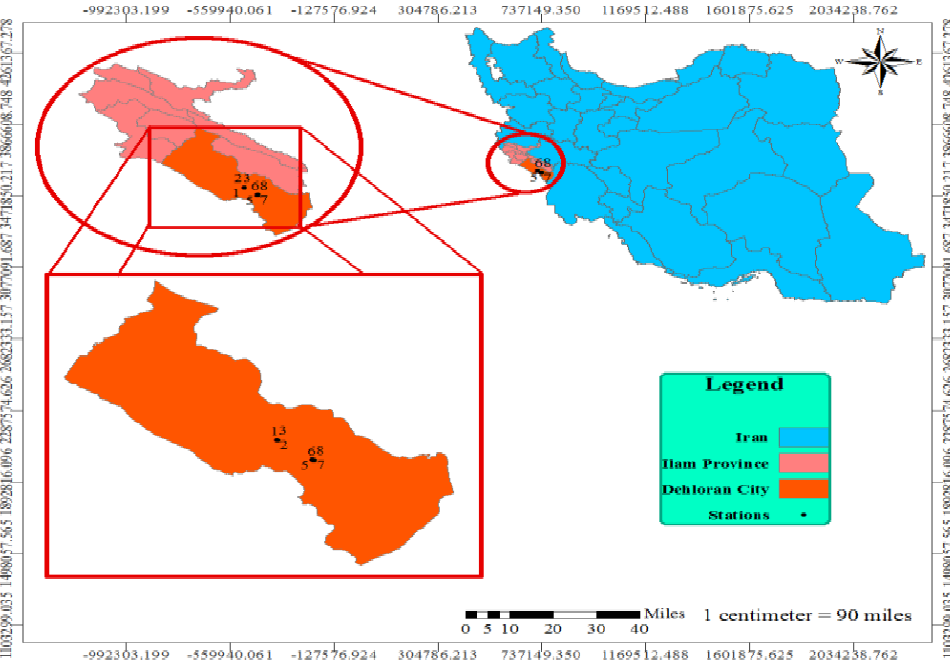
Figure 1. study locations Dashte Akbar 1 named well No. 1; Dashte Akbar 2, Dashte Akbar 3, Bare Bije 1, Bare Bije 2, Bare Bije 3, Bare Bije 4, and Bare Bije 5 were called well No. 2, 3, 4, 5, 6, 7, and 8,